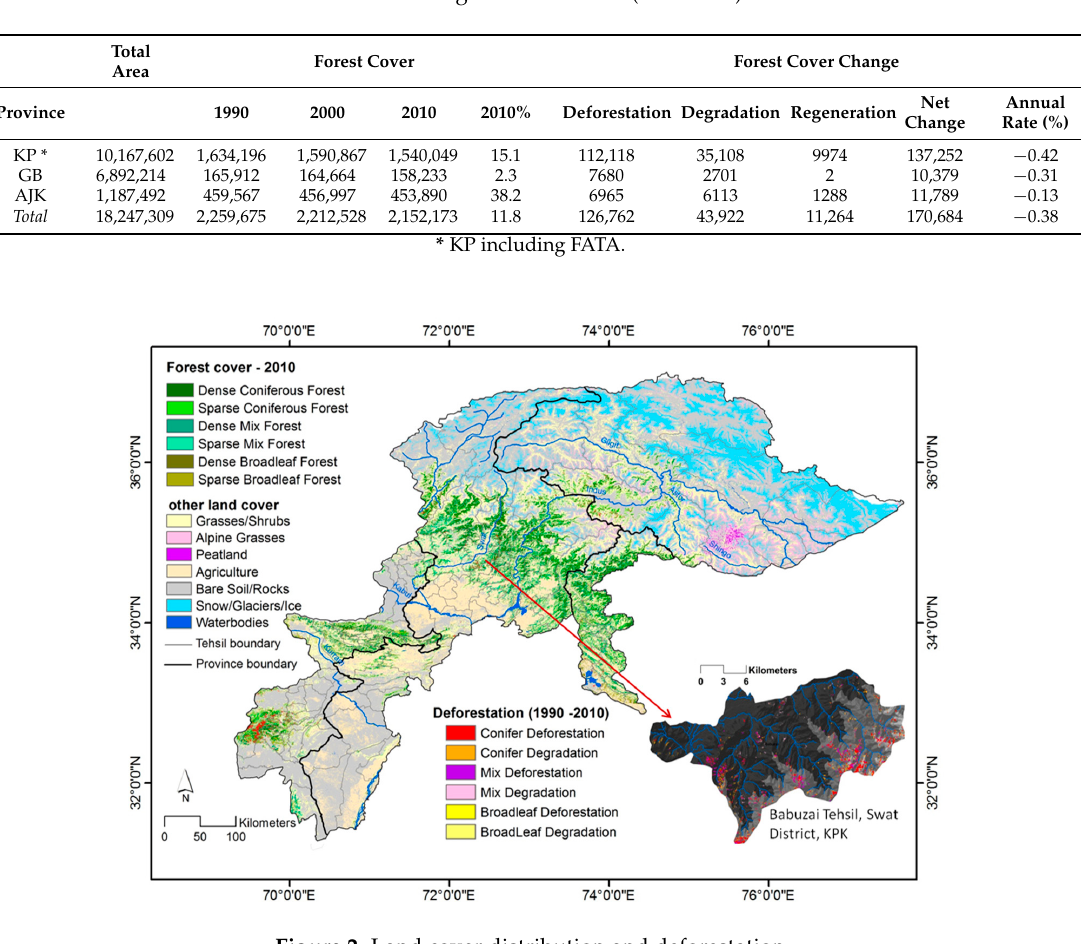
Table 4. Change of forest cover (area in ha).